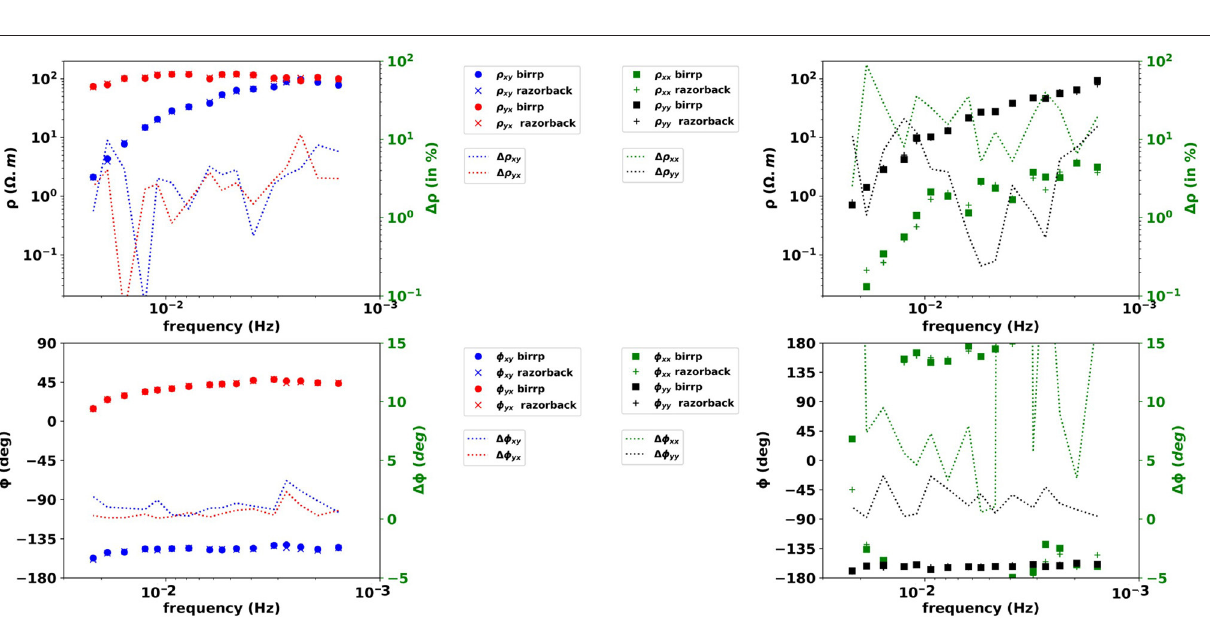
( Figure 7 , lower part) show less variability in the same frequency band as soon as distant RRs are used. Similar to the ME results, φ yx exhibits a 35 ◦ shift, centered on the 0.1 Hz frequency, but with a narrower frequency band imprint. There are